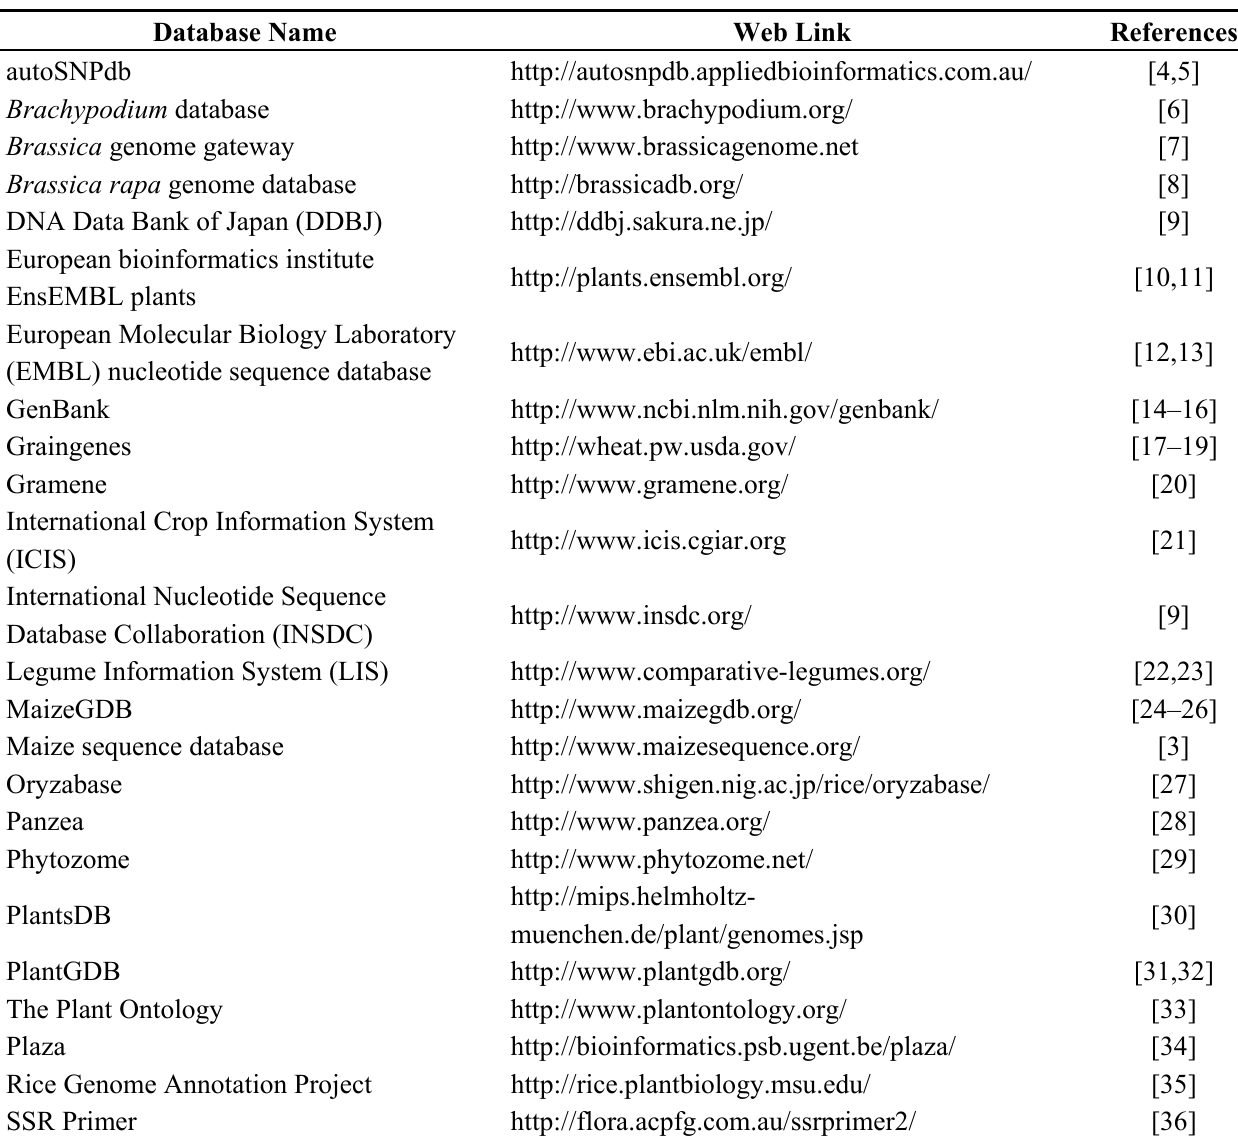
Table 1. Examples of genomic databases related to crop